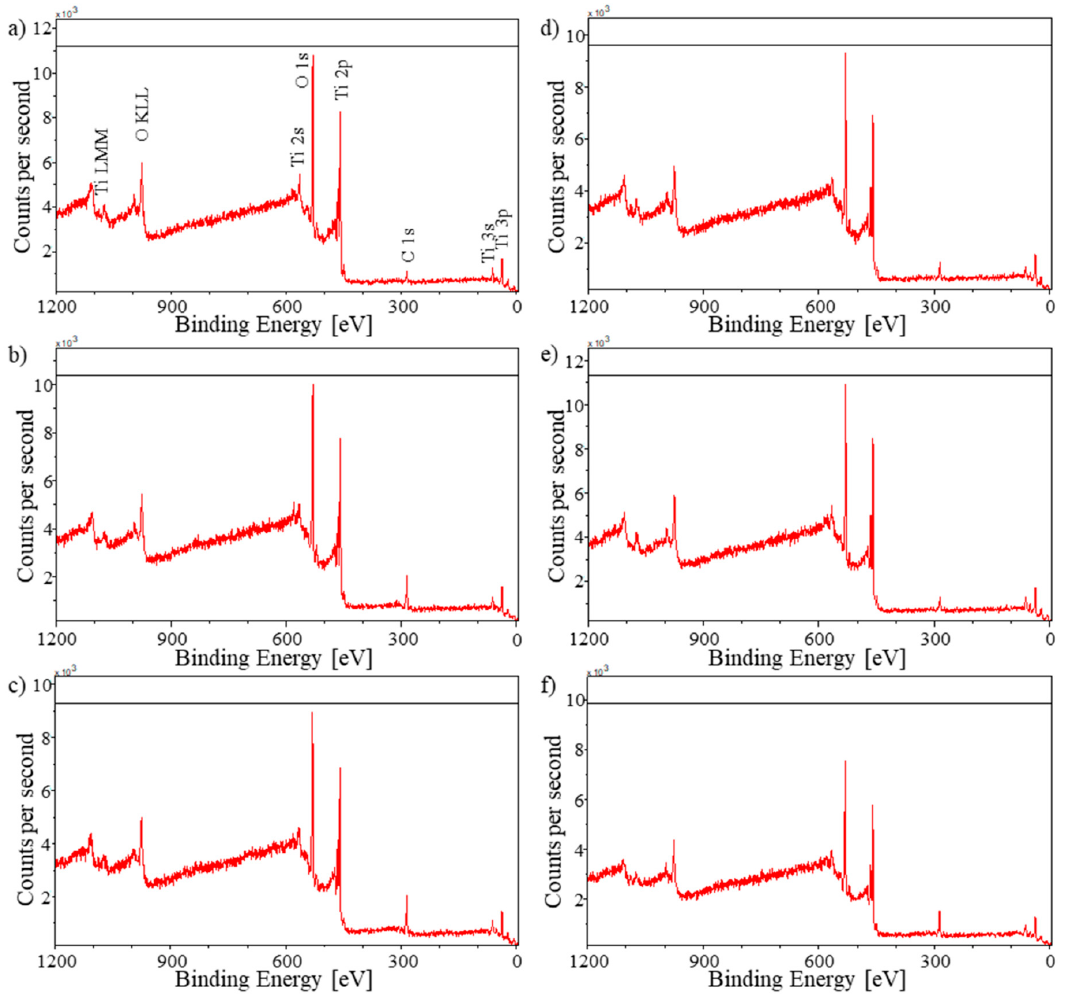
Figure 4. X-ray photoelectron spectra obtained for the materials: ( a ) TiO 2 5 nm; ( b ) 1%CuPc@TiO 2 5 nm; ( c ) 1%ZnPc@TiO 2 5 nm; ( d ) TiO 2 15 nm; ( e ) 1%CuPc@TiO 2 15 nm; ( f ) 1%ZnPc@TiO 2 15 nm.